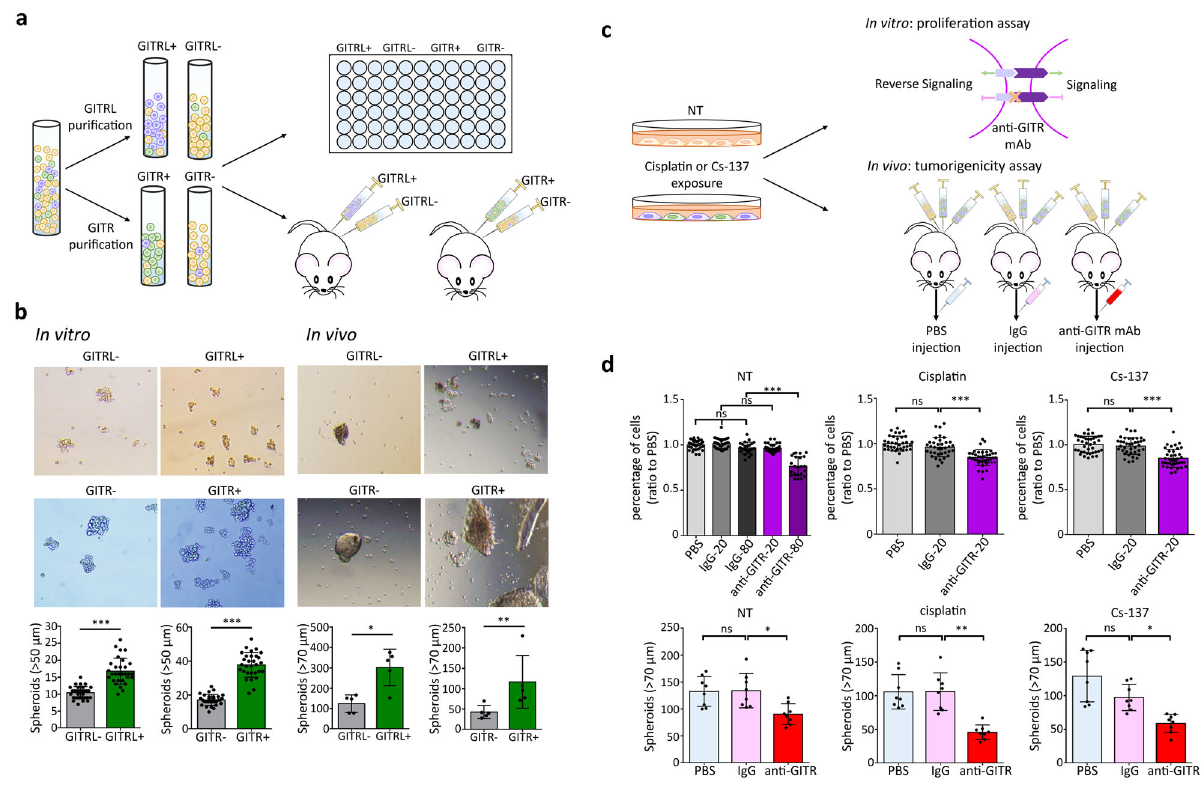
Fig. 4 GITR/GITRL signaling contributes to tumorigenicity and cell proliferation in CRL5946 mesothelioma cells. a Schematic representation of the experimental design and analysis of sphere formation from puri fi ed GITRL + or GITR + cells from CRL5946 cells in vitro and in vivo. b Representative images of in vitro cells that formed mesospheres (>50 μ m) and quanti fi cation of spheroid growth from the puri fi ed GITRL + , GITRL − , GITR + , or GITR − populations in ultralow attachment plate for 14 days (left panel, n = 30 for each group). The puri fi ed cells were intraperitoneally injected into NOD/SCID mice to grow mesospheres. Representative images of spheres were taken on day 30 after cell injection. The size of mesospheres over 70 μ m has been quanti fi ed to compare the tumorigenicity between GITRL + /GITRL − or GITR + /GITR − (right panel, n = 6 for each group). c Schematic representation of the experimental design by using the GITR neutralizing monoclonal antibody to verify the requirement of GITR/GITRL axis for cell proliferation and tumorigenicity. d Upper panel: The CRL5946 cells were treated with or without 2 μ g/mL cisplatin or 7.5 Gy Cs-137 irradiation. Compared with PBS or IgG, cell proliferation was attenuated by GITR neutralized mAb in concentration at 80 μ g/mL in nontreated cells ( n = 23) or at 20 μ g/mL in cisplatin or Cs-137 treated cells ( n = 32 for each group). Bottom panel: NOD/SCID mice were injected with nonpretreated, cisplatin-pretreated (2ug/ml for 24 h), or Cs-137 irradiation-pretreated (7.5 Gy, 24 h before injection) cells ( n = 8 each treatment group) for 24 days. All mice received intraperitoneal injection of PBS, 100 μ g IgG, or anti-GITR on day 0 and day 7. Spheres were decreased in anti-GITR-injected group, whereas PBS- or IgG-injected group did not. All data shown represent the mean ± standard deviation; * P < 0.05; ** P < 0.01; *** P < 0.0001 vs PBS or IgG group, determined by one-way ANOVA analysis of variance with Bonferroni post-hoc